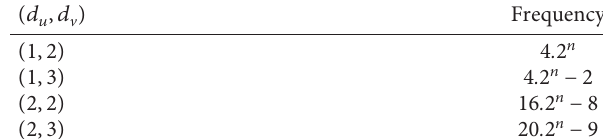
Figure 37: Second Gourava index.